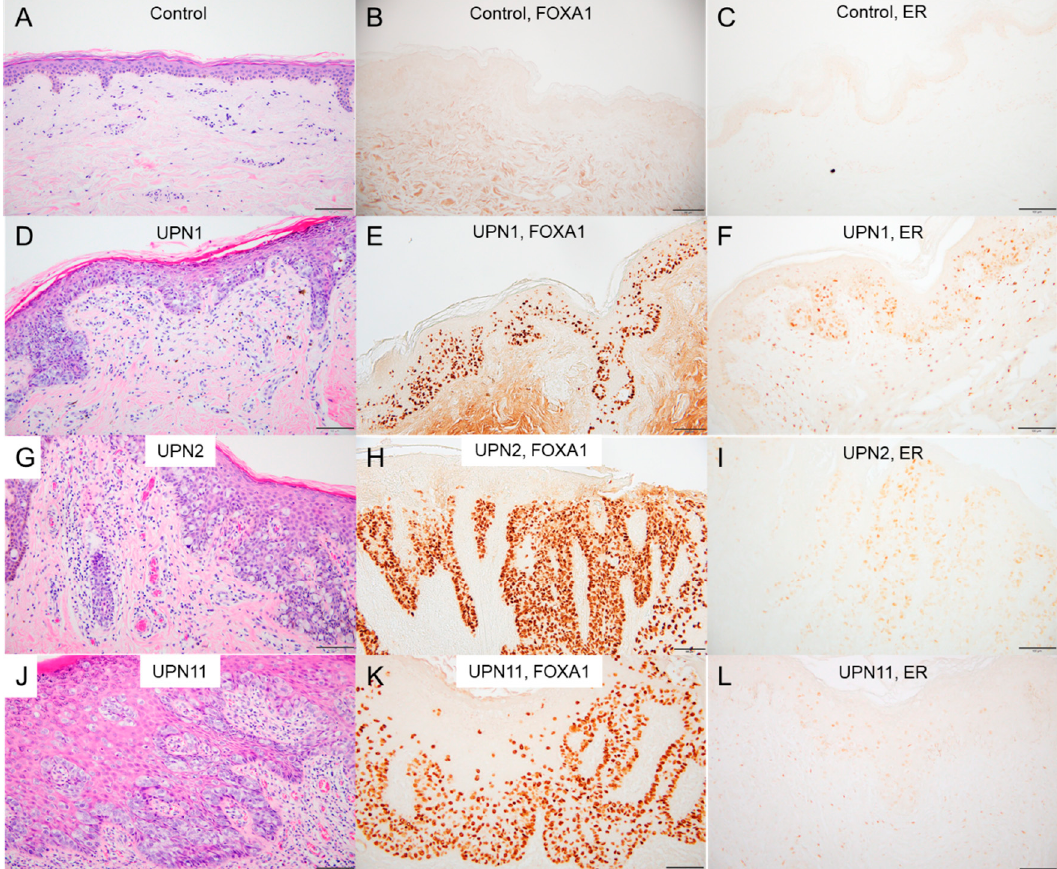
Figure 4. Immunohistochemical analyses of EMPD lesions and normal epidermis. Skin specimens from a healthy donor ( A – C ); UPN1, the case with the GAS6-FOXA1 fusion ( D – F ); UPN2, the case with the FOXA1 promotor mutation ( G – I ); and UPN11, a case with no detectable mutation ( J – L ) stained with anti-FOXA1 ( B , E , H , K ) and anti-estrogen receptor alpha ( C , F , I , L ) antibodies (scale bars, 100 μ m).